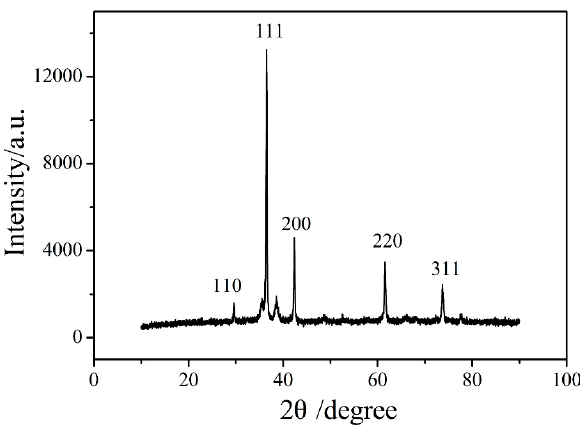
Figure 2. The X-ray di ff raction (XRD) pattern of Cu 2 O NPs. Figure 2. The X ‒ ray diffraction (XRD) pattern of Cu 2 O NPs. Figure 2. The X ‒ ray diffraction (XRD) pattern of Cu 2 O NPs.